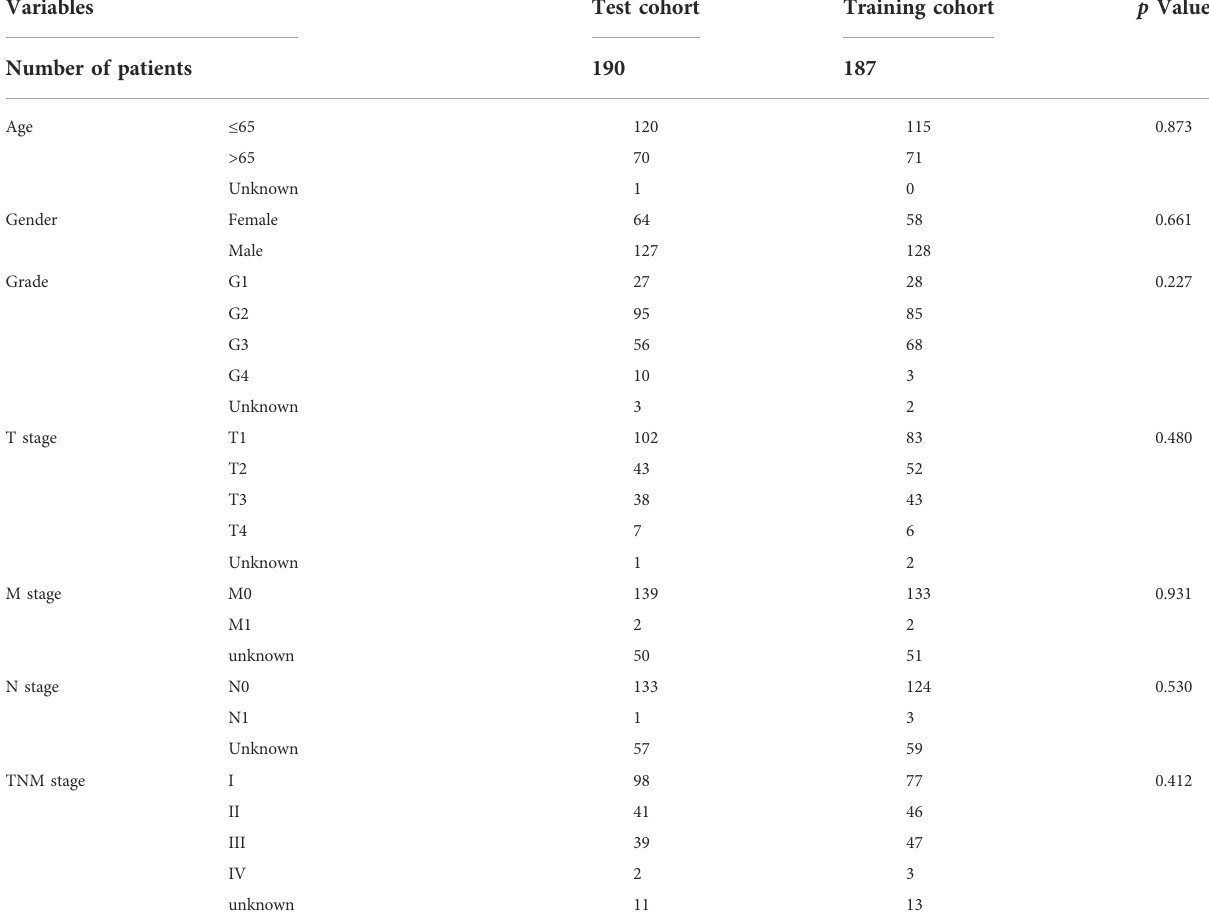
TABLE 1 Clinicopathlogical features of high- and low-risk